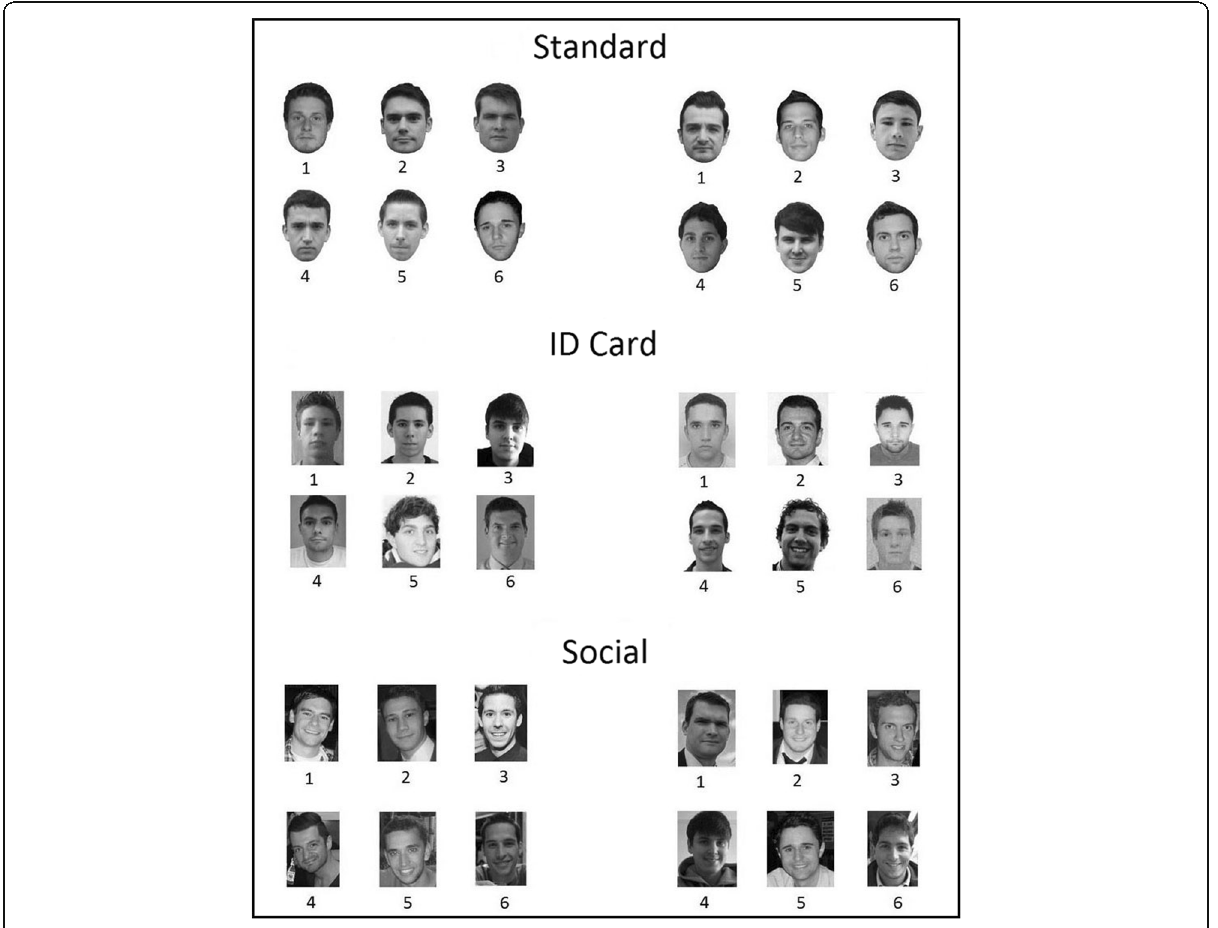
Fig. 3 Illustration of the face images in Experiment 2, depicting target-present lineups ( left ) and target-absent lineups ( right